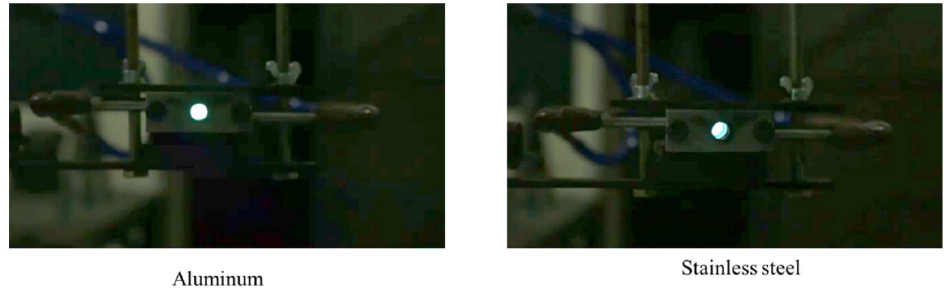
Figure 15. Stable flame appearance in horizontal vortex combustors .